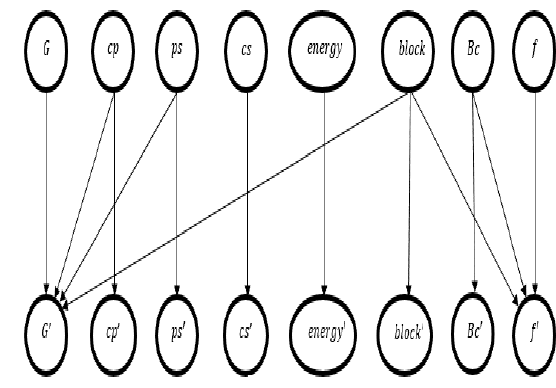
Fig. 4: Bayesian Network For Member